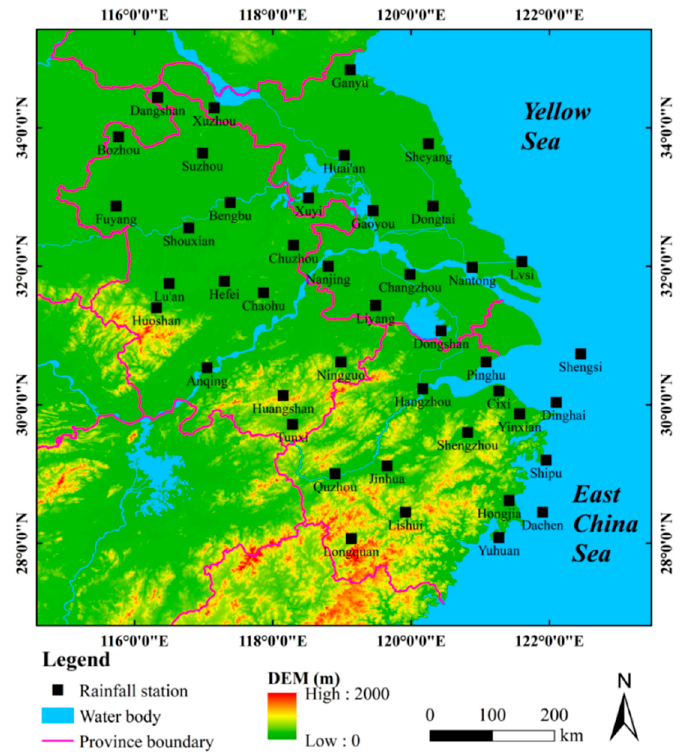
Figure 1. Location of the study region in eastern China.